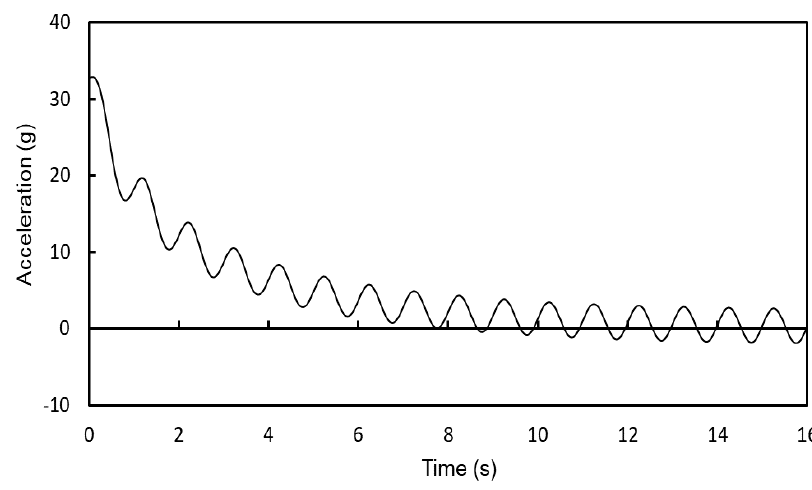
Figure 8. Cont ( a ) Simulation results for the acceleration of the nonlinear vibration isolator module